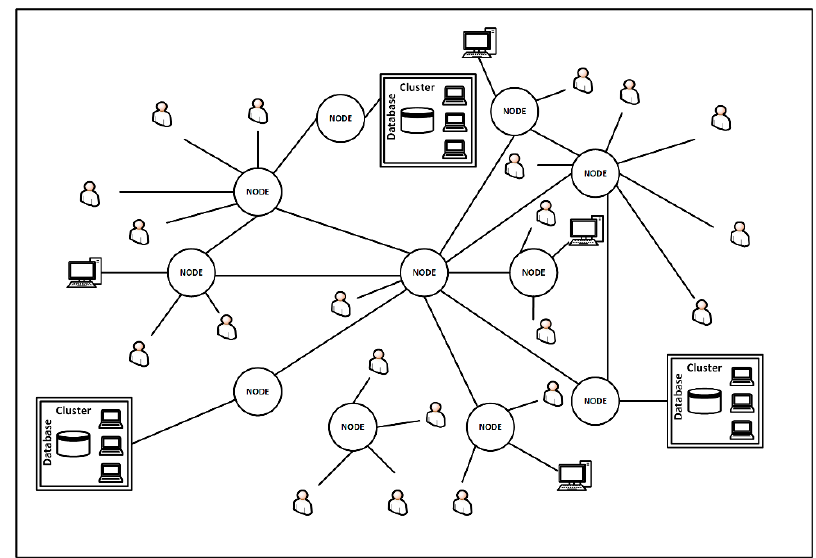
Figure 4. Decentralized blockchain network in the VE.